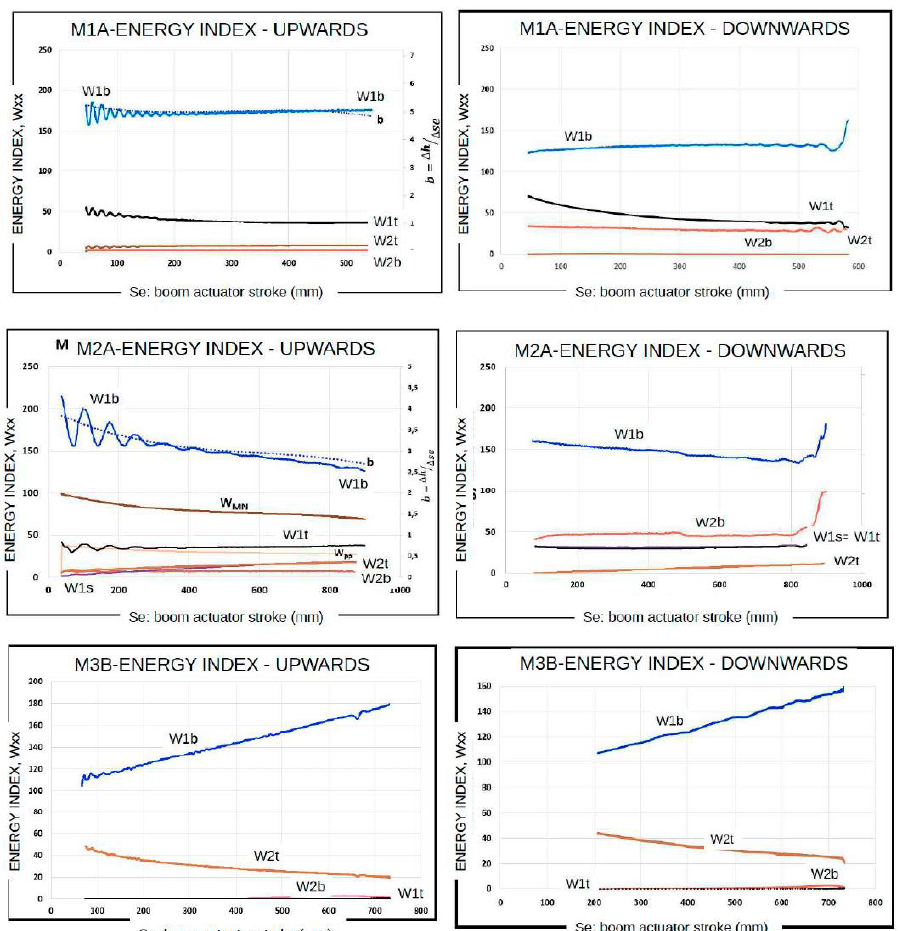
Figure 4. Graphs corresponding to the energy index, Wx , versus the boom actuator stroke for different types of machine.